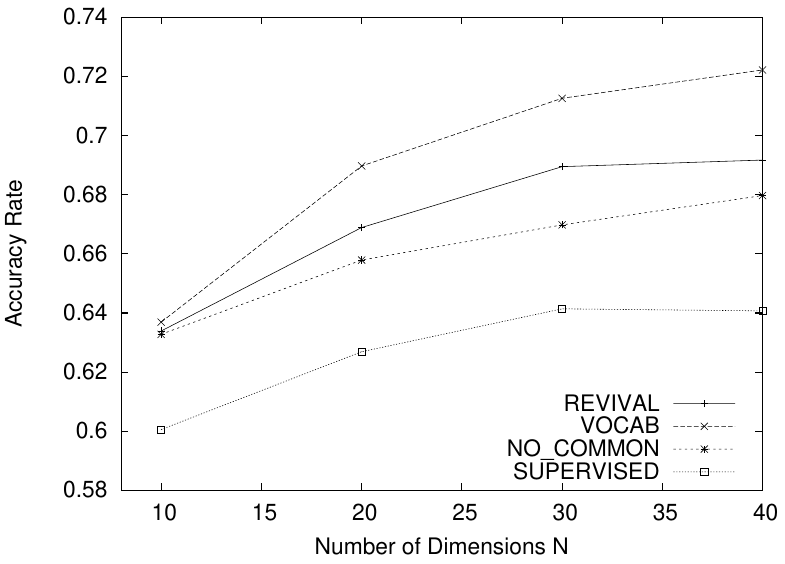
Figure 9. Accuracy rate for Wang database: